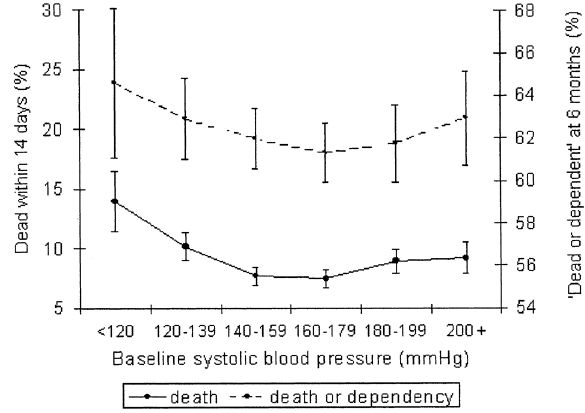
Fig. 1 Proportion of patients from the International Stroke Trial who died within 14 days (solid lines) or were dead or dependent at six months (dashed lines) by baseline SBP. Circles and squares indicate the mean per- centage of patients who had died within 14 days and patients who had died or were dependent at six months, respectively, within each blood pressure subgroup; 95% CIs are represented by T bars. (From Leonardi- Bee J, Bath PMW, Phillips SJ, et al. Stroke. 2002;33:1315–1320 with per- mission from publisher,